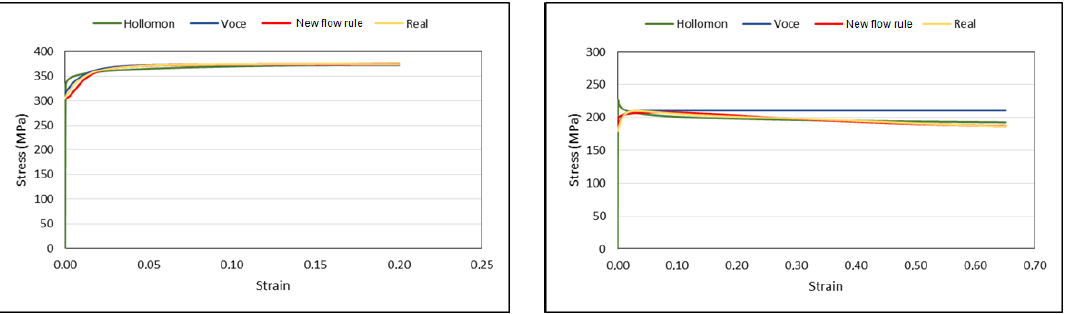
Figure 7. Comparison of the three material flow rules at room temperature ( left ); and at high temperature (250 °C) ( right ) versus the experimental curve for AA5754 with N2 state.